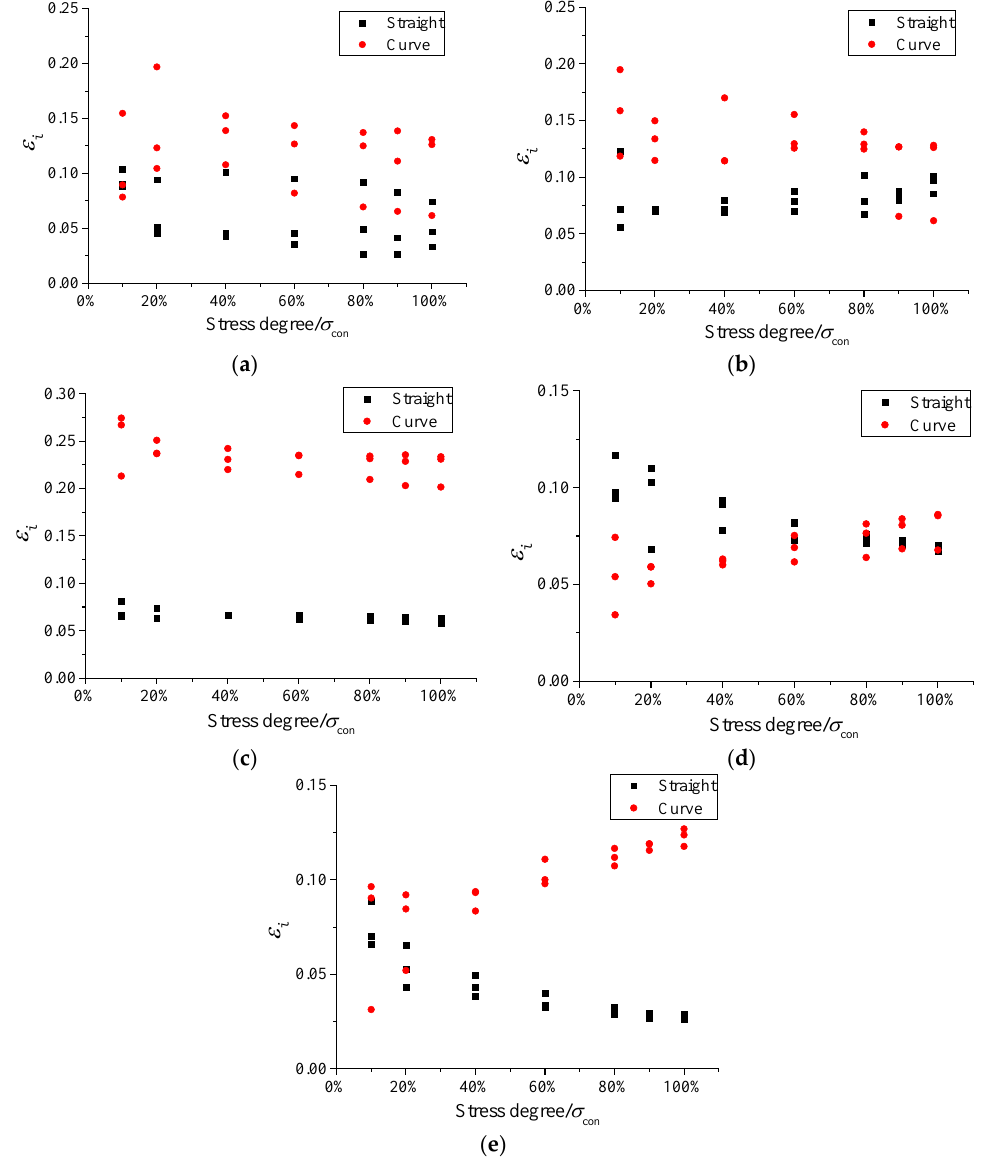
Figure 11. Instantaneous ε i at each stress degree: ( a ) 1 wire; ( b ) 3 wires; ( c ) 12 wires; ( d ) 19 wires; and ( e ) 22 wires.